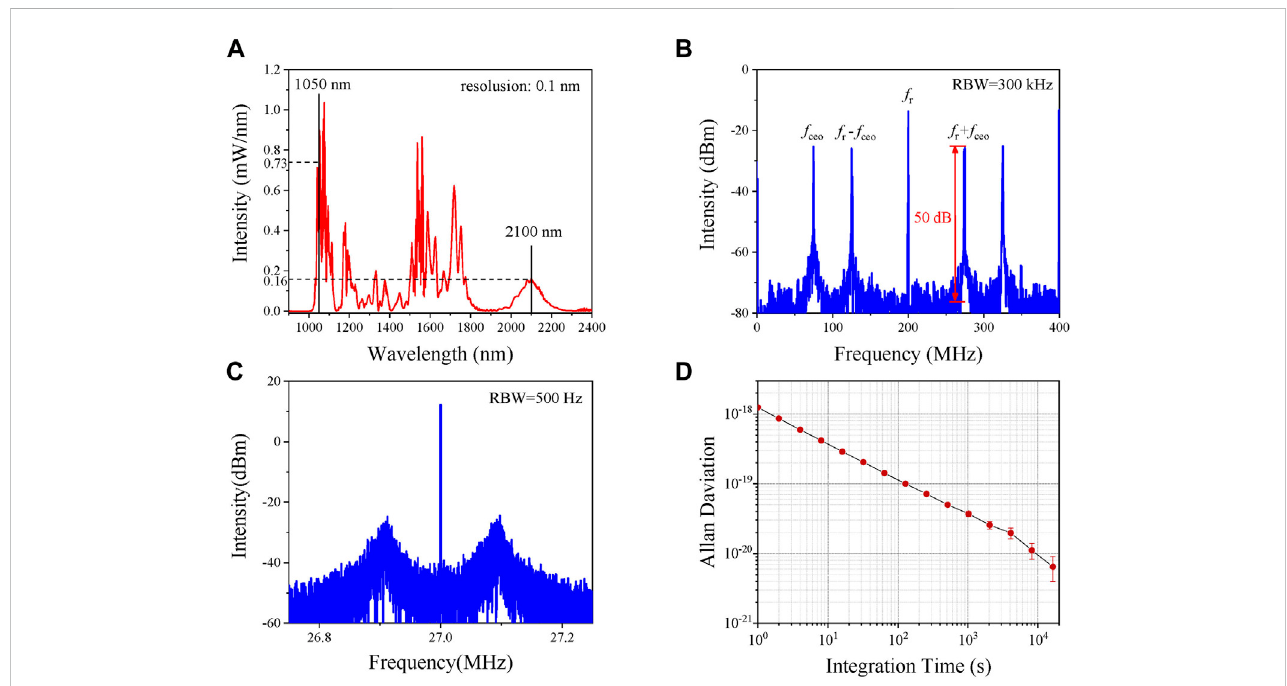
FIGURE 4 (A) Supercontinuumoveranoctavespanfor f ceo detection; (B) f ceo spectrum; (C) thefractionalphaselocked f ceo + f r ; (D) theinstabilityofthelocked f ceo